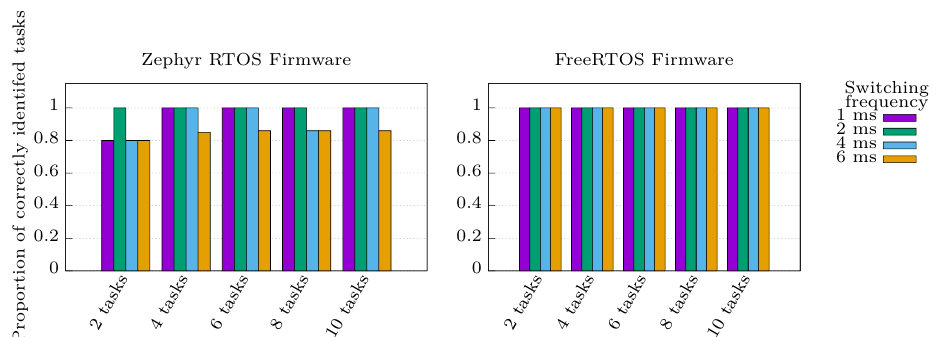
Figure 5: Left: Correctly identified tasks for Zephyr firmware; Right: